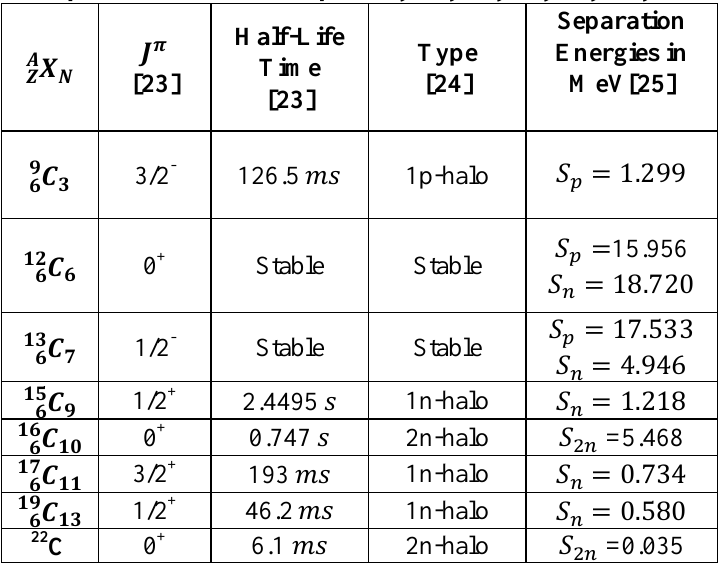
Table 2: Properties of carbon isotopes 9 C , 12 C, 13 C, 15 C, 16 C, 17 C, 19 C and 22 C.